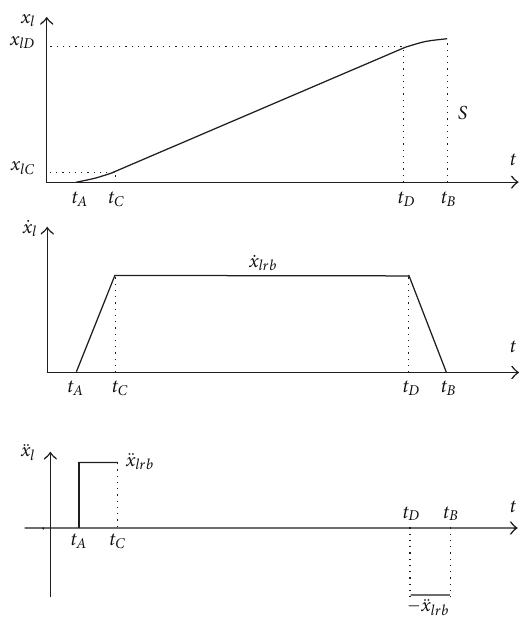
Figure 6: Motion of robot in x l